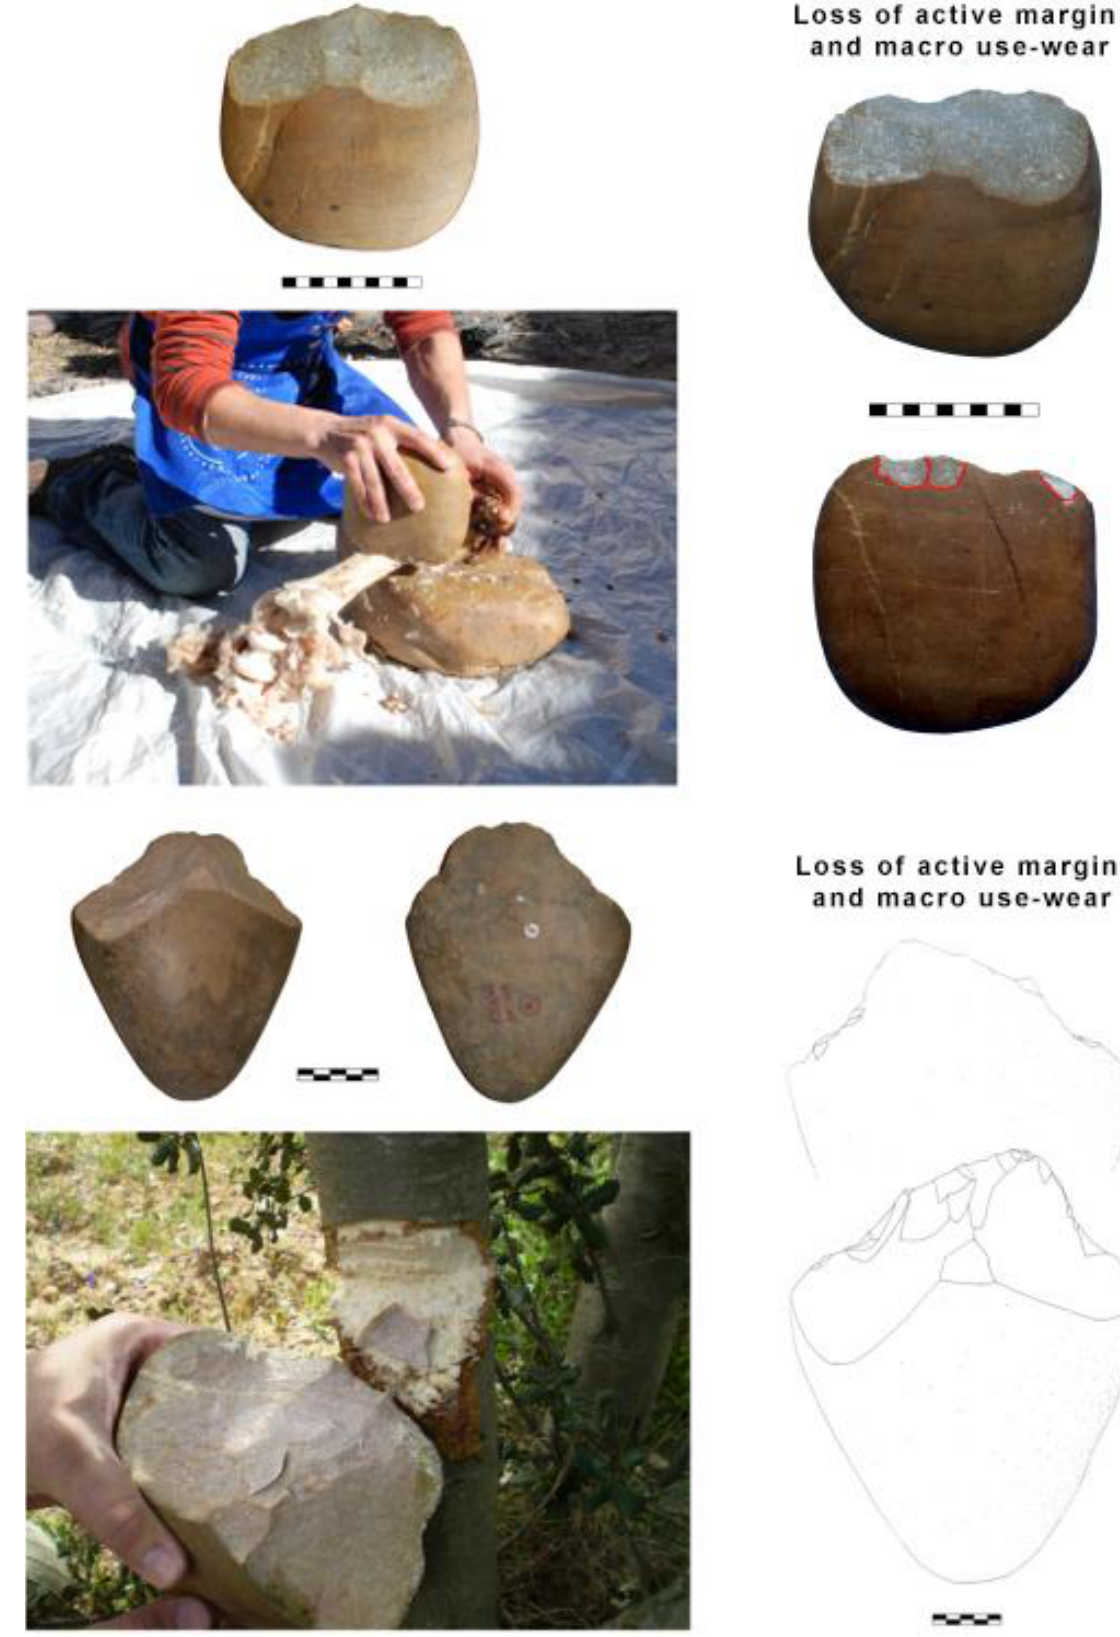
Figure 7. Experimental cutting of wood (fresh Quercus ilex with outer bark) and bone (fresh Bos Taurus) with worked pebbles. The scale bars are divided into 1 cm